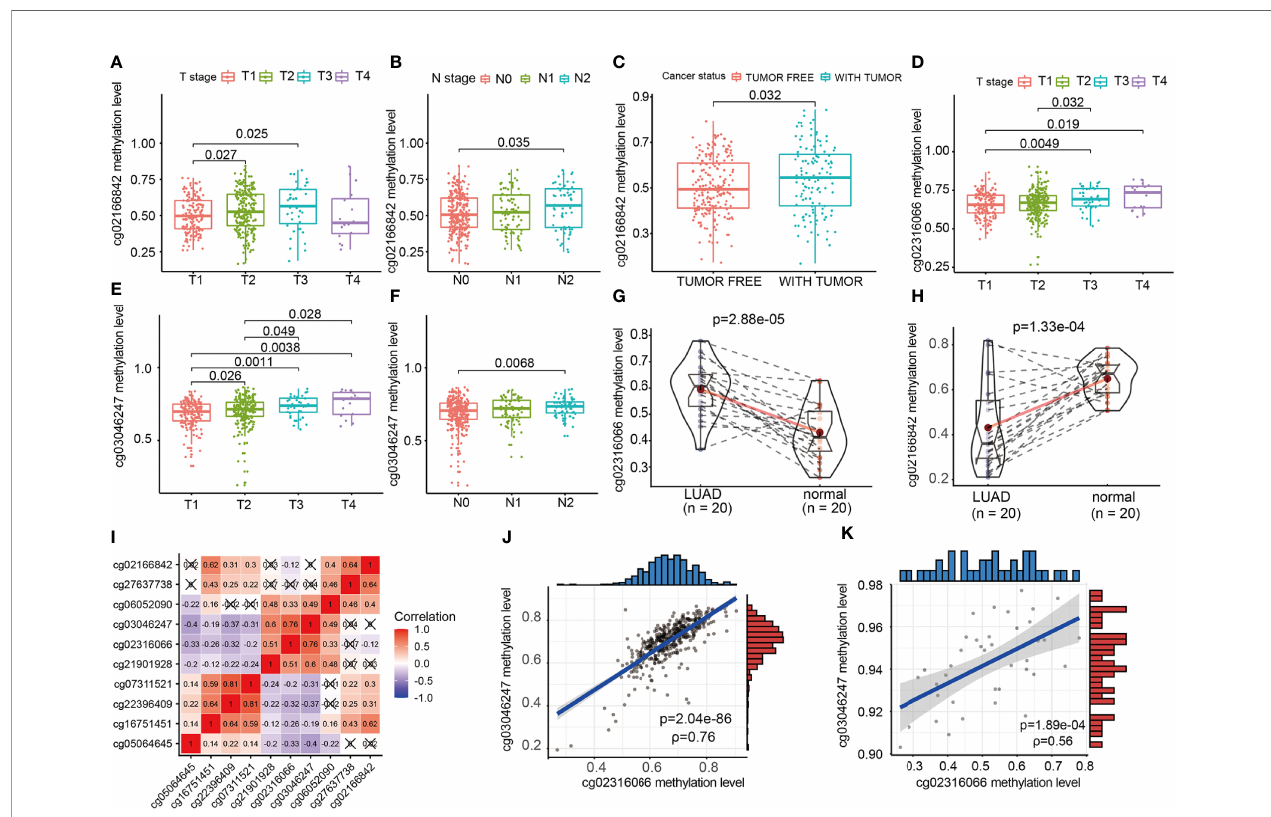
FIGURE 6 | The relationship of EGFR CpG sites DNA methylation levels and clinicopathologic parameters. (A) Association of cg02166842 DNA methylation levels with T stage. (B) Association of cg02166842 DNA methylation levels with N stage. (C) Association of cg02166842 DNA methylation levels with cancer status. (D) Association of cg02316066 DNA methylation levels with T stage. (E) Association of cg03046247 DNA methylation levels with T stage. (F) Association of cg03046247 DNA methylation levels with N stage. (G) DNA methylation levels of cg02316066 in normal and LUAD samples. (H) DNA methylation levels of cg02166842 in normal and LUAD samples. (I) Correlation heat map of DNA methylation levels at 10 OS-associated CpG sites. (J) Association between the DNA methylation of cg02316066 and cg03046247 in the TCGA LUAD cohort. (K) Association between the DNA methylation of cg02316066 and cg03046247 in external validation